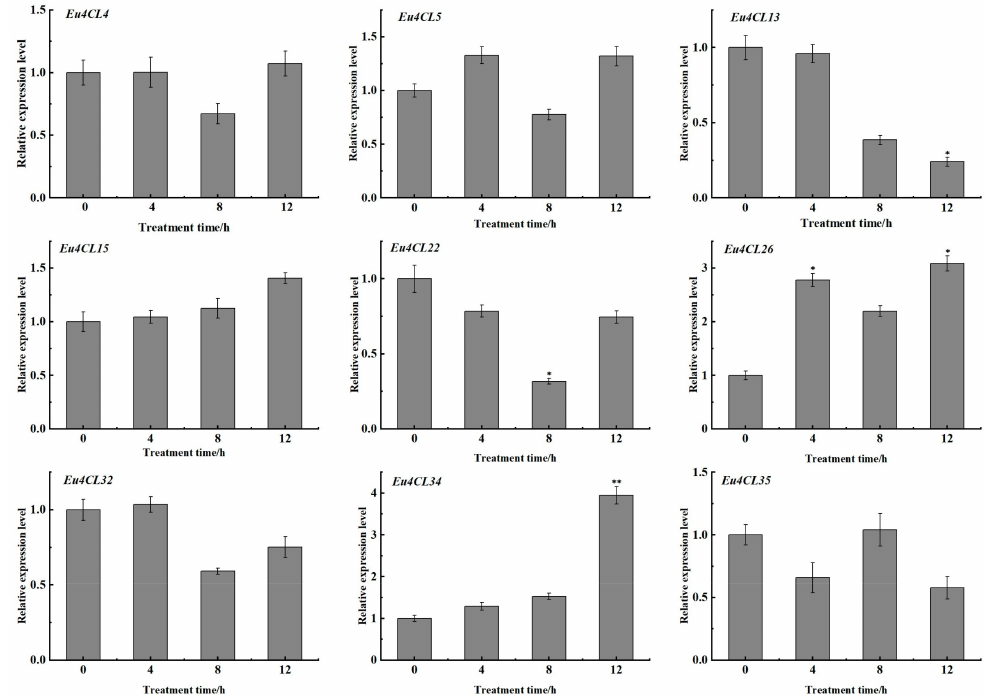
Figure 6. Expression profiles of selected Eu4CL genes under WeJA stress conditions. Error bars show the standard deviation of three biological replicates. * means significant correlation at a level of 0.05. ** means significant correlation at a level of